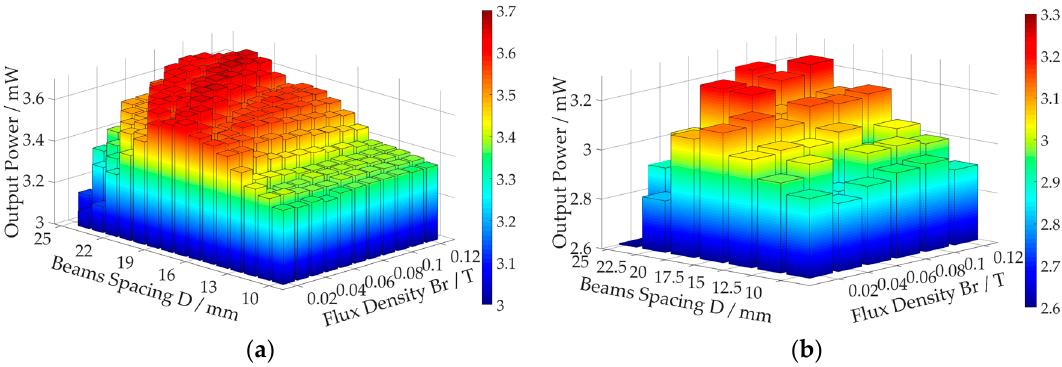
Figure 8. Output power maximum at different D and B r : ( a ) Simulation; ( b ) Experiment.